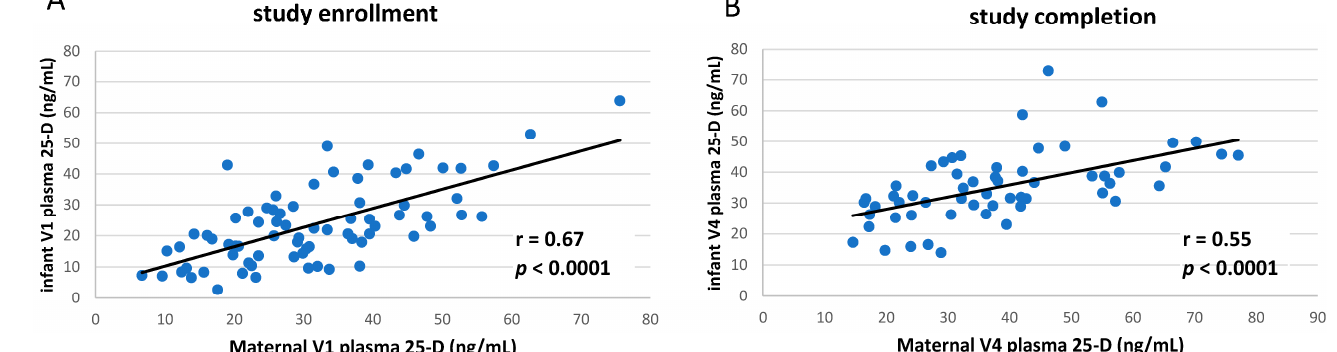
Figure 1. Correlation of maternal and infant 25-hydroxyvitamin D during study. Circulating con- centrations of total 25-hydroxyvitamin D (vitD status) measured in plasma obtained from mothers and their breastfeeding infants at ( A ) V1 study enrollment or ( B ) V4 completion, 3 months later (all subjects; blinded study cohorts). Pearson linear correlations